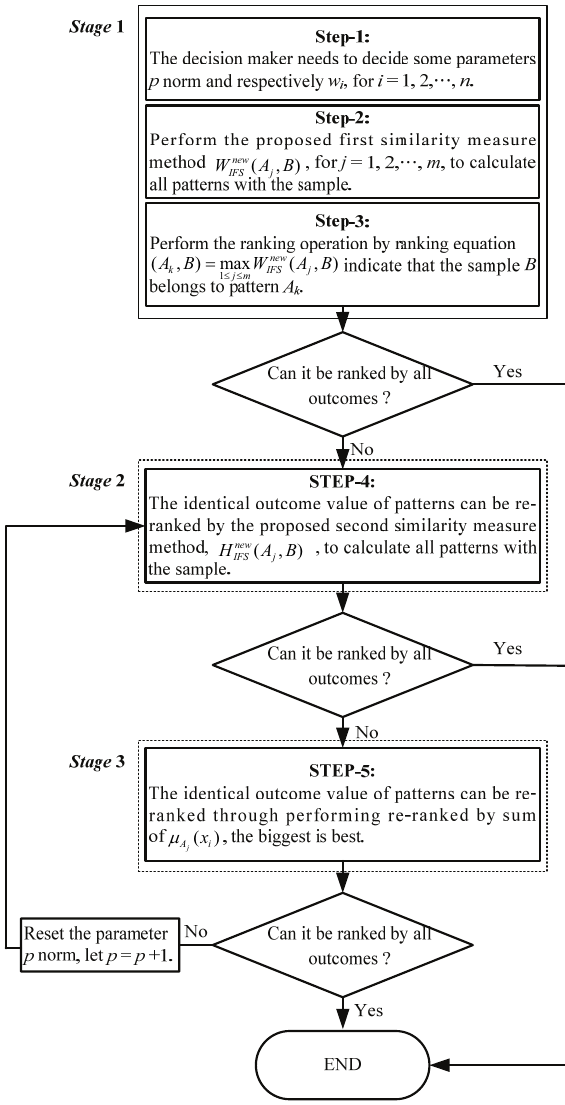
Fig. 3. The flowchart of our proposed integrated similarity measure